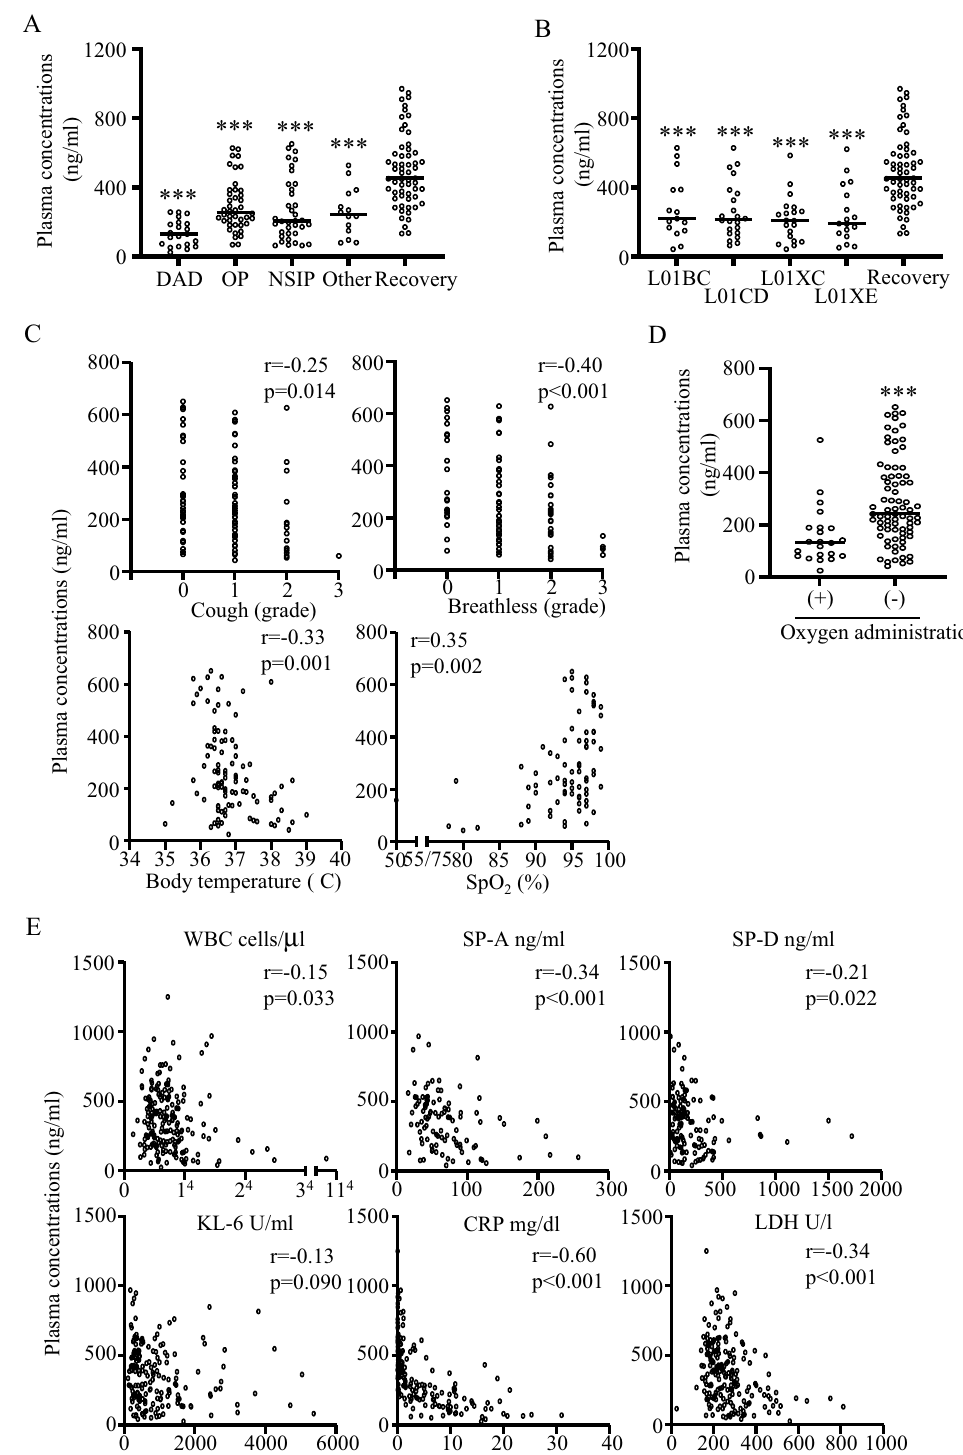
Figure 3. Association of LPC(14:0) with DILD patterns, causal drugs, symptom severities, and other DILD biomarkers. ( A ) Plasma LPC(14:0) concentrations for each DILD pattern in acute and recovery phase DILD patients. *** p < 0.001 vs. recovery phase. ( B ) Plasma LPC(14:0) concentrations in acute phase DILD patients treated with specific causal drugs and recovery phase DILD patients. L01BC: pyrimidine analogs; L01CD: taxanes; L01XC: monoclonal antibodies; L01XE: protein kinase inhibitors. *** p < 0.001 vs. recovery phase. ( C ) Plasma LPC(14:0) concentrations with cough and breathlessness scores, body temperatures, and SpO 2 levels. ( D ) Plasma LPC(14:0) concentrations in acute phase DILD patients with or without oxygen administration. *** p < 0.001. ( E ) Plasma LPC(14:0) concentrations with other DILD